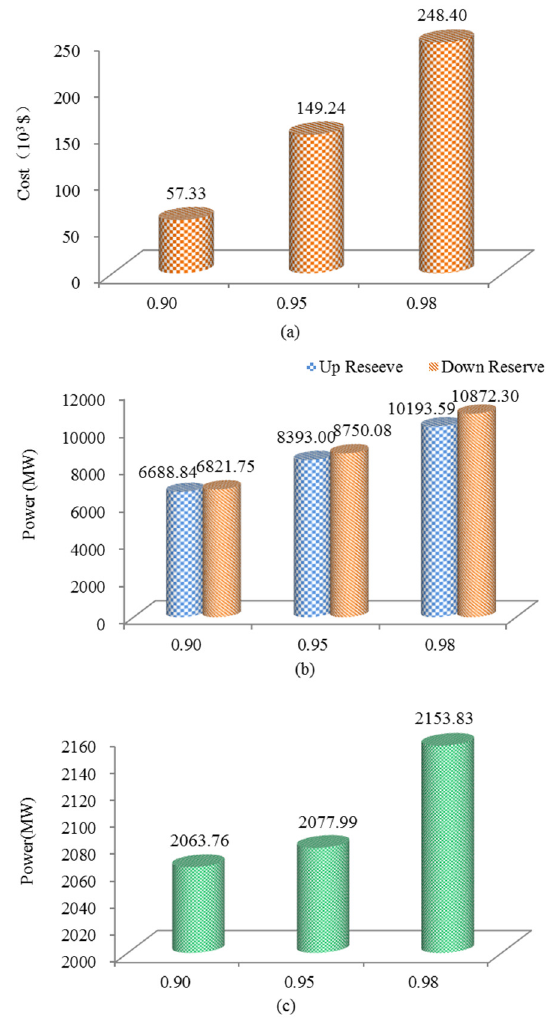
Figure 15. The results of Case 2 at different confidence degrees; ( a ) is the spinning reserve cost; ( b ) is the up ‐ reserve and down ‐ reserve of wind power and ( c ) is the total output of SLBFLs.